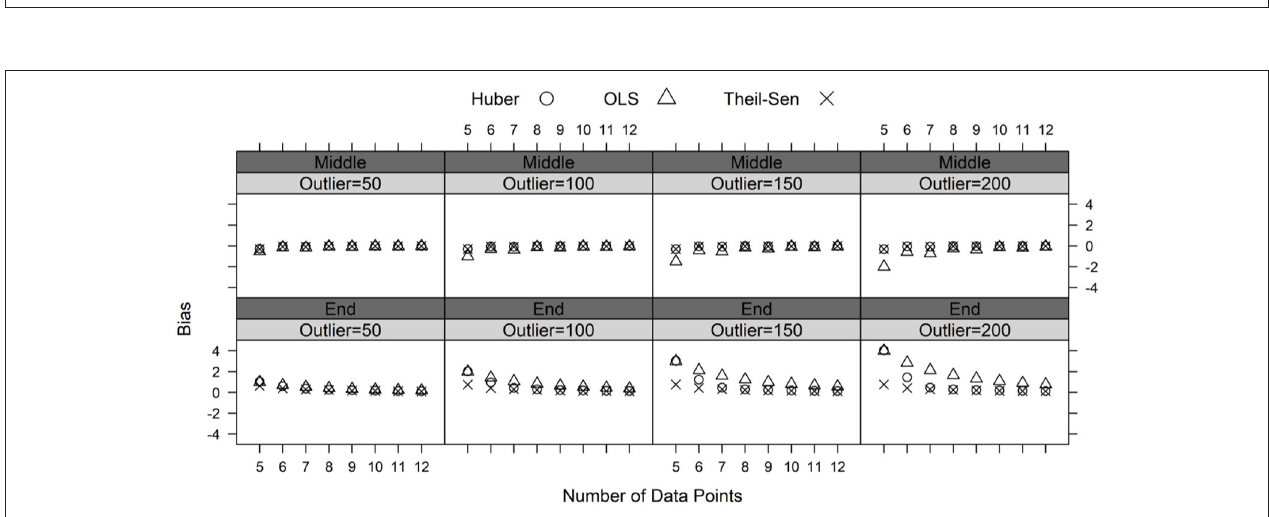
FIGURE 2 | Bias and RMSE for the estimated slopes when no outlier is present in the progress monitoring data. (Note that the data for the OLS, Huber M -estimator, and Theil-Sen methods are almost overlapping for most data points).